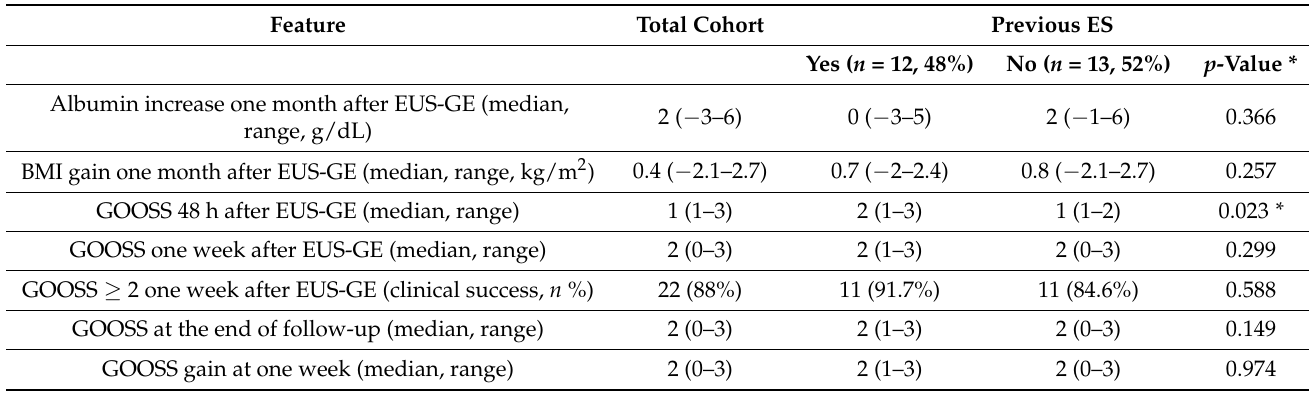
Table 2. Impact on the nutritional status of the EUS-GE based on the presence of a previous duodenal stent in a cohort of 25 patients with technical